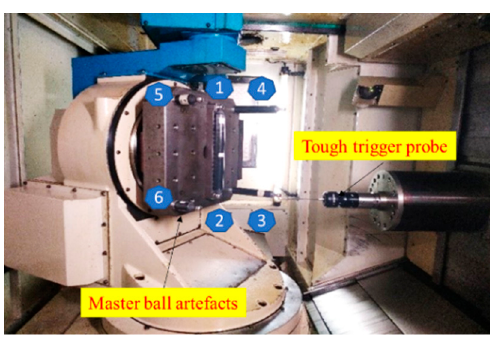
Figure 5. SAMBA measurement in HU40-T five-axis machine tool, Numbers 3, 4, 5, and 6 indicate the four master ball artefacts, Numbers 1 and 2 indicate the scale ball artefact.